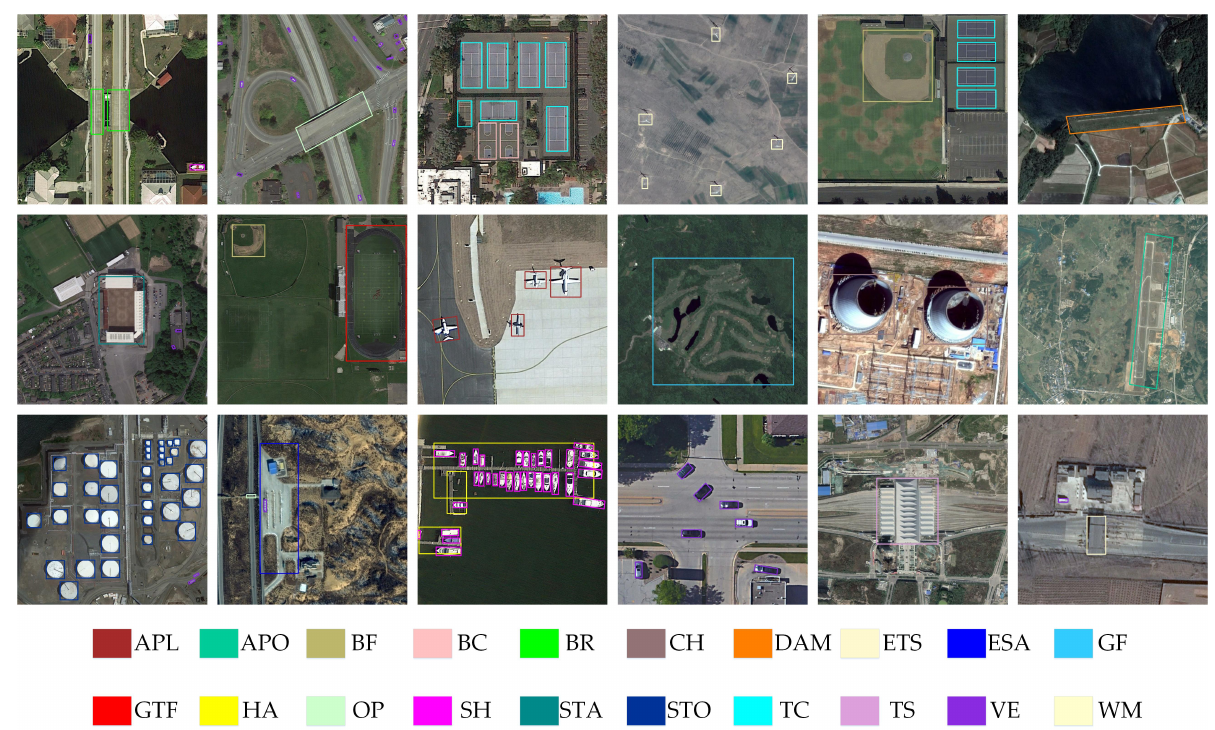
Figure 7. The visualized detection results on